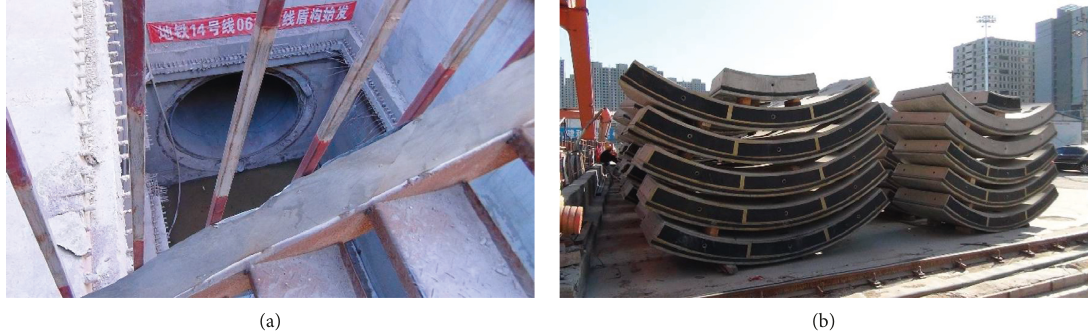
Figure 10: Beijing subway line 14: (a) the shield-driven tunnel entrance and (b) the precast concrete